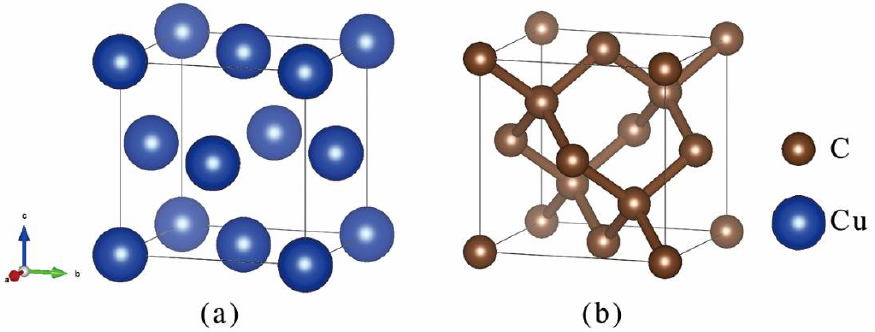
Figure 1. Crystal structures of Cu and diamond: ( a ) a face-centered cubic copper unit cell; ( b ) a face-centered cubic diamond unit cell.